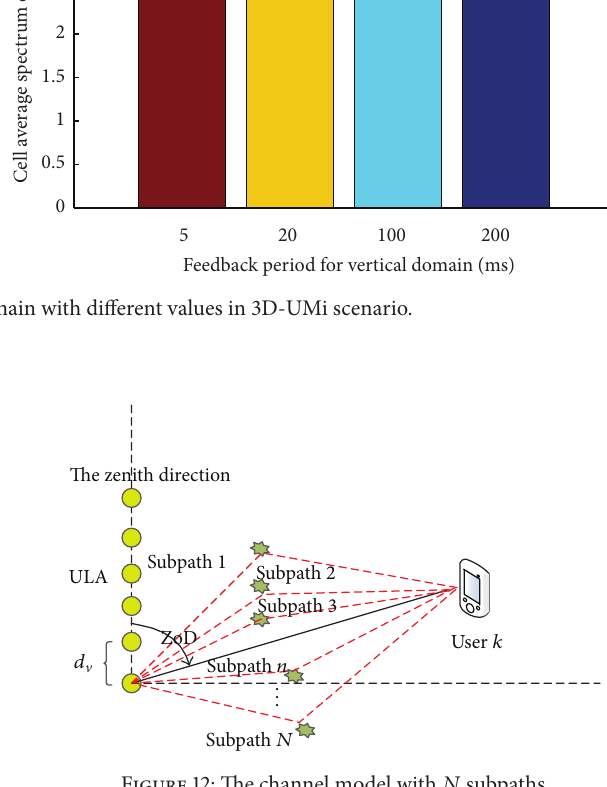
Figure 12: The channel model with 𝑁